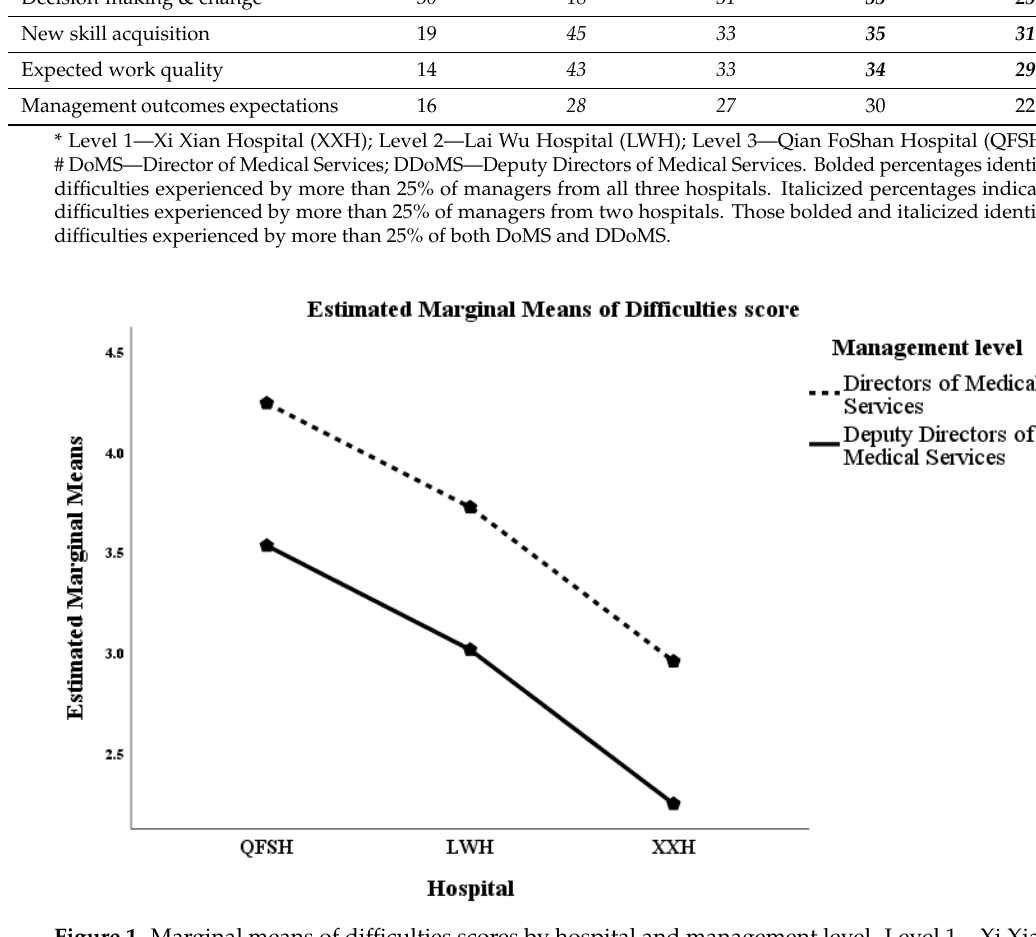
Figure 1. Marginal means of difficulties scores by hospital and management level. Level 1—Xi Xian Hospital (XXH); Level 2—Lai Wu Hospital (LWH); Level 3—Qian FoShan Hospital (QFSH).